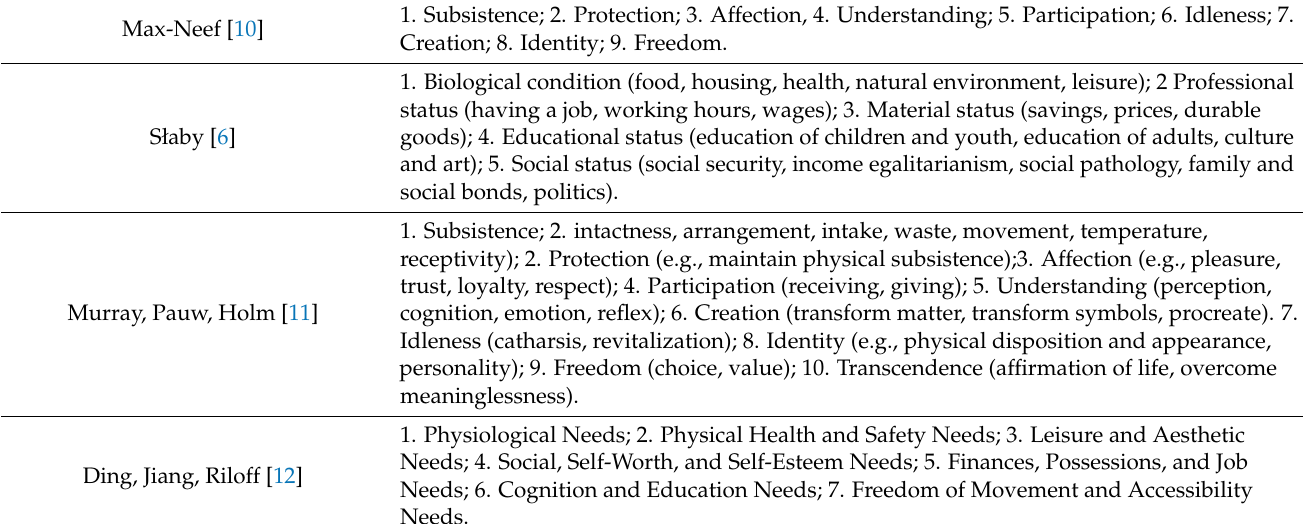
Table 1. Categories of human